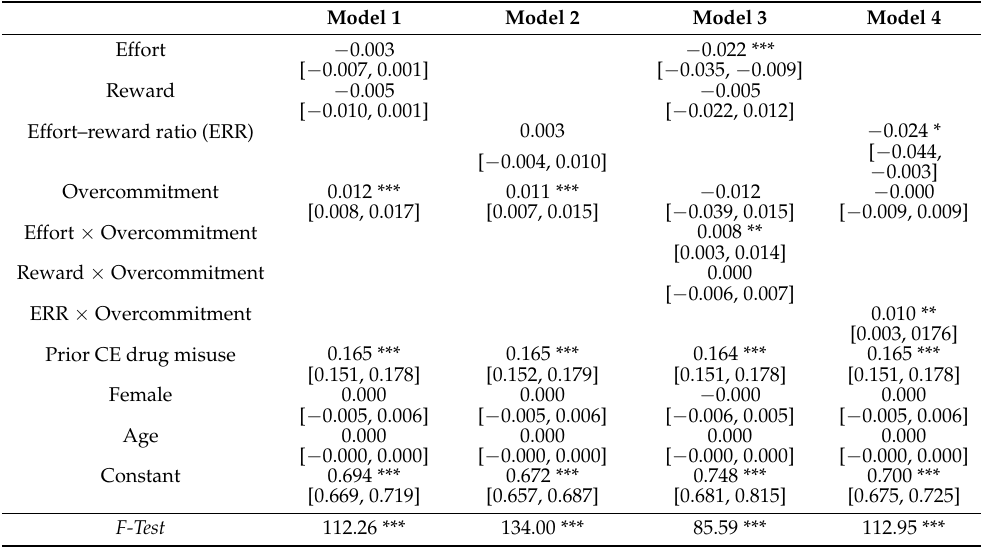
Table 2. Logarithmic 12 month misuse frequency of CE drugs (measured at t 2 ), based on ordinary least squares regression models ( N =